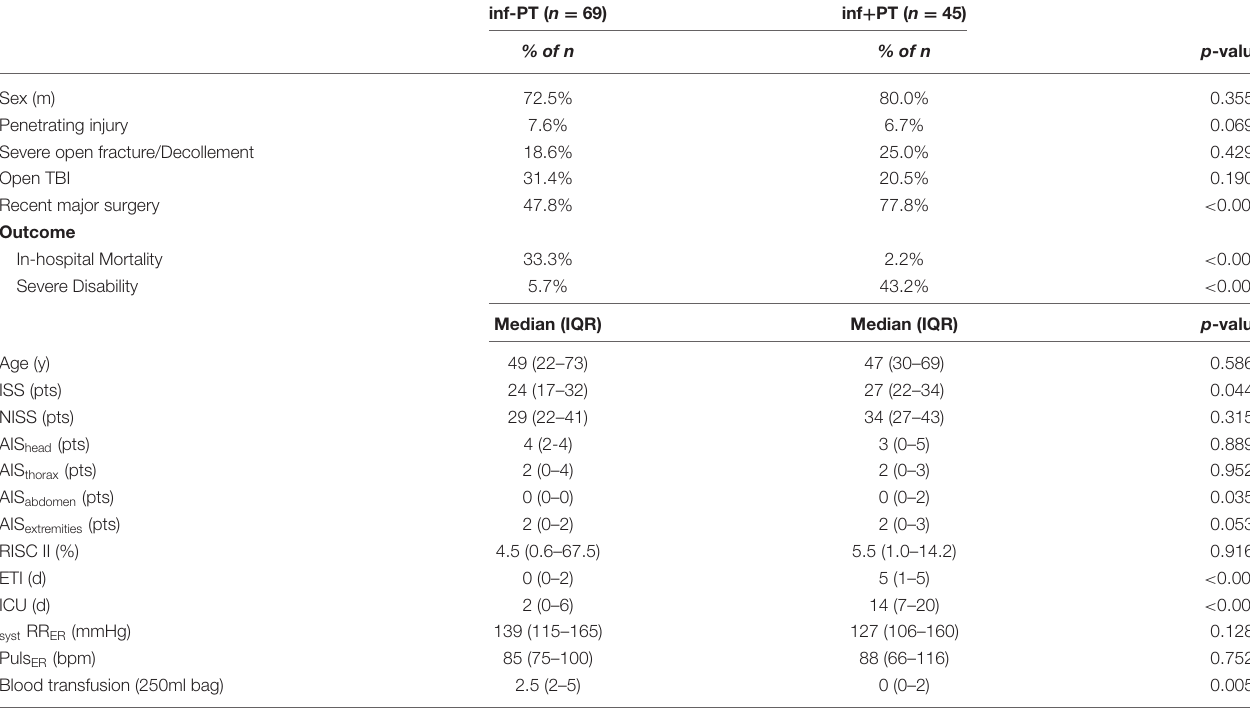
TABLE 1 | Demographic and injury characteristics stratified by the incidence of post-traumatic